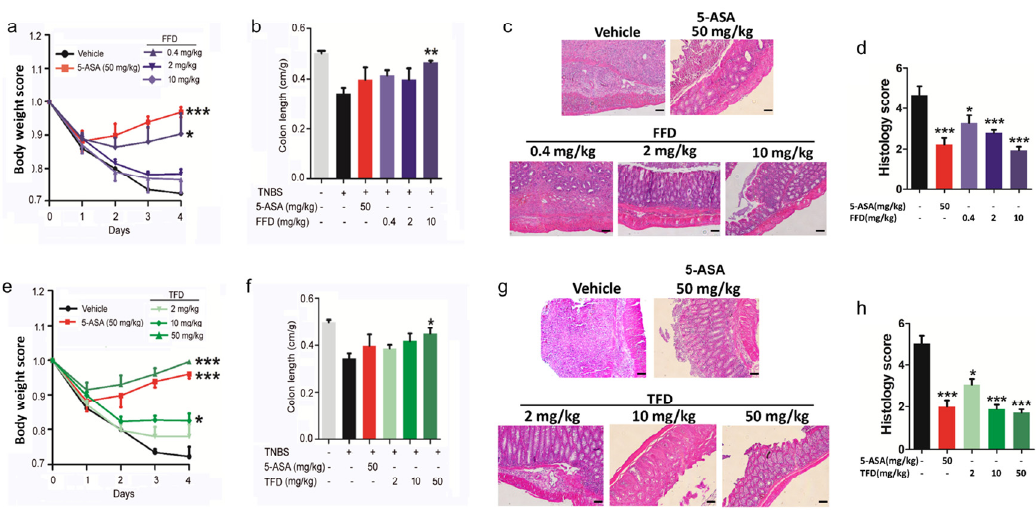
Figure 3. Effects of Fexofenadine (FFD) or Terfenadine (TFD) on TNBS-induced acute colitis model. Beginning 3 days before intrarectal TNBS injection, drugs were orally delivered until sacrifice at 5 days. 2.5% TNBS was administered by intrarectal injection to 8-week-old C57BL/6 mice. ( a ) Body weights of controls and FFD-treated groups. ( b ) Colon lengths of controls and FFD-treated groups. ( c ) H&E staining of colons from the FFD-treated group. ( d ) The quantification of the histological score. ( e ) Body weights of controls and TFD-treated groups. ( f ) Colon lengths of controls and TFD-treated groups. ( g ) H&E staining of colons from the TFD-treated group. ( h ) The quantification of the histological score. Statistical analysis was done to compare the treatment groups and vehicle groups. n = 6 per group. Data are mean ± SE; * p < 0.05, ** p < 0.01, *** p < 0.001. (Scale bar, 100 µ